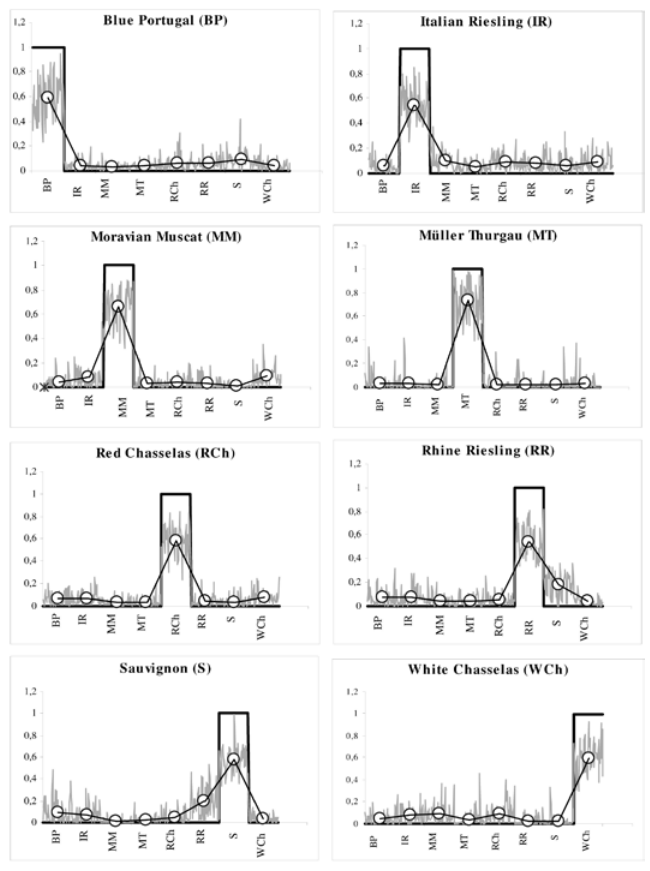
Fig. 3 - Neural networks of eight chosen varieties.